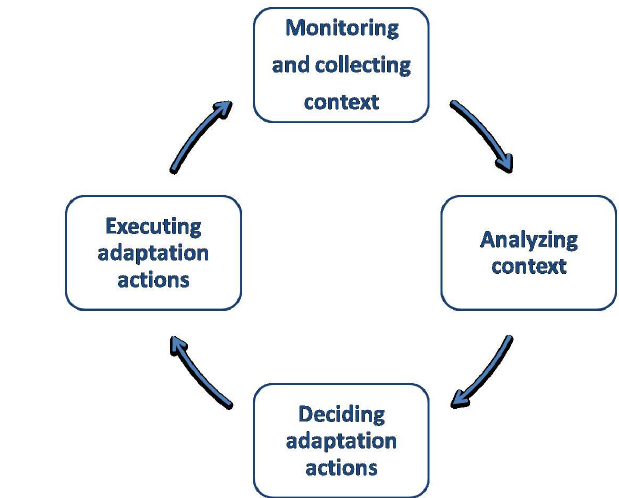
Figure 1. Context aware application